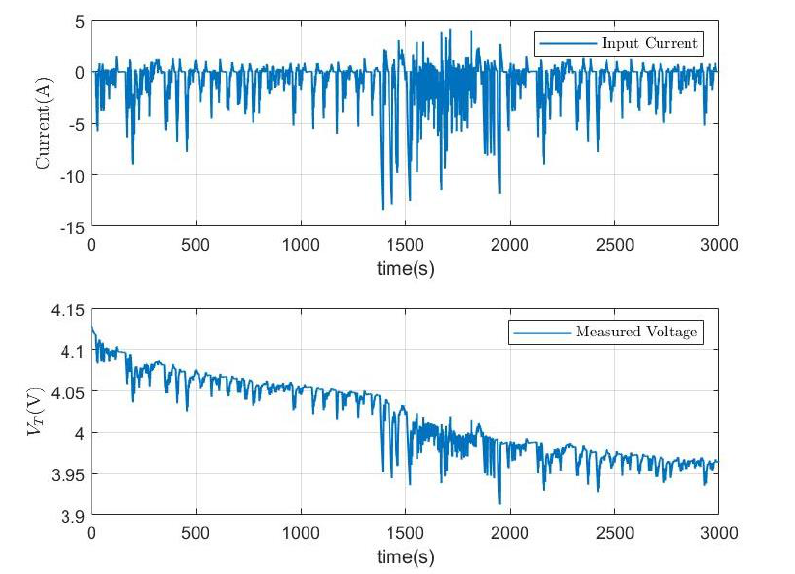
Figure 7. Current and voltage of the validation